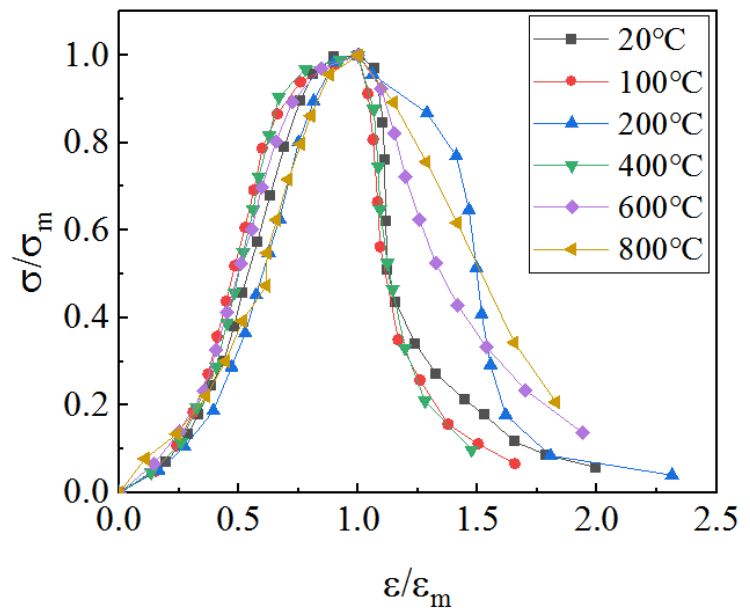
Figure 4. Full stress – strain curve.